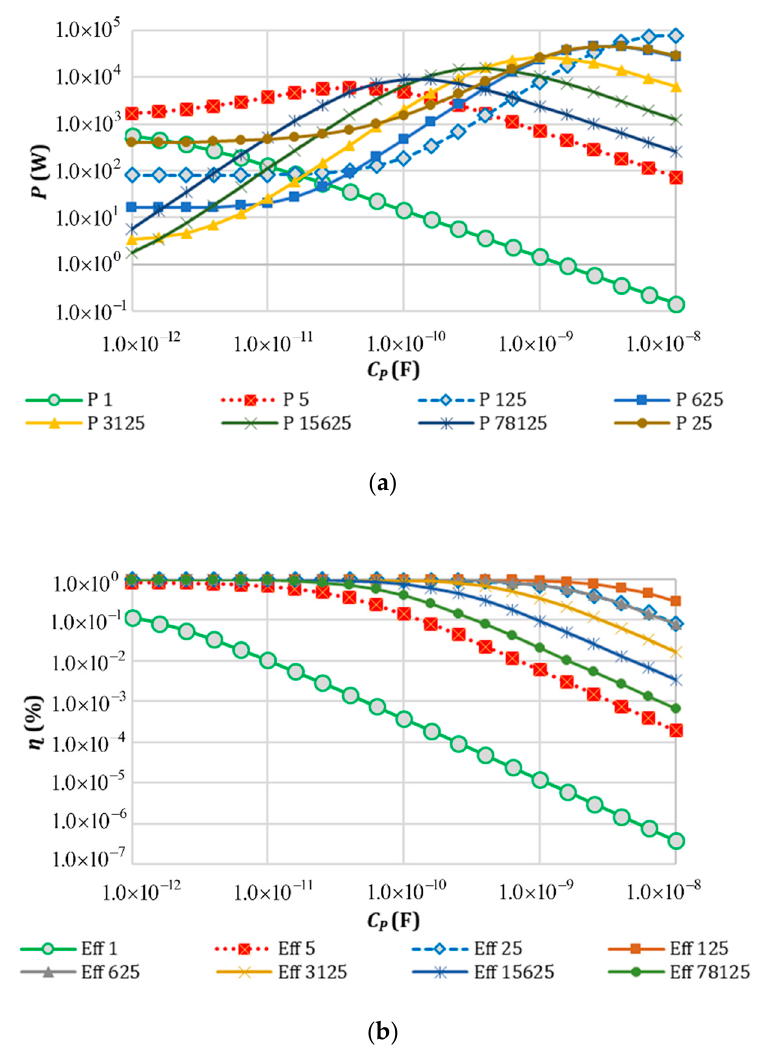
Figure 15. E ff ects of parasitic capacitance and load-resistance variations upon: ( a ) power behavior; ( b ) e ffi ciency behavior.